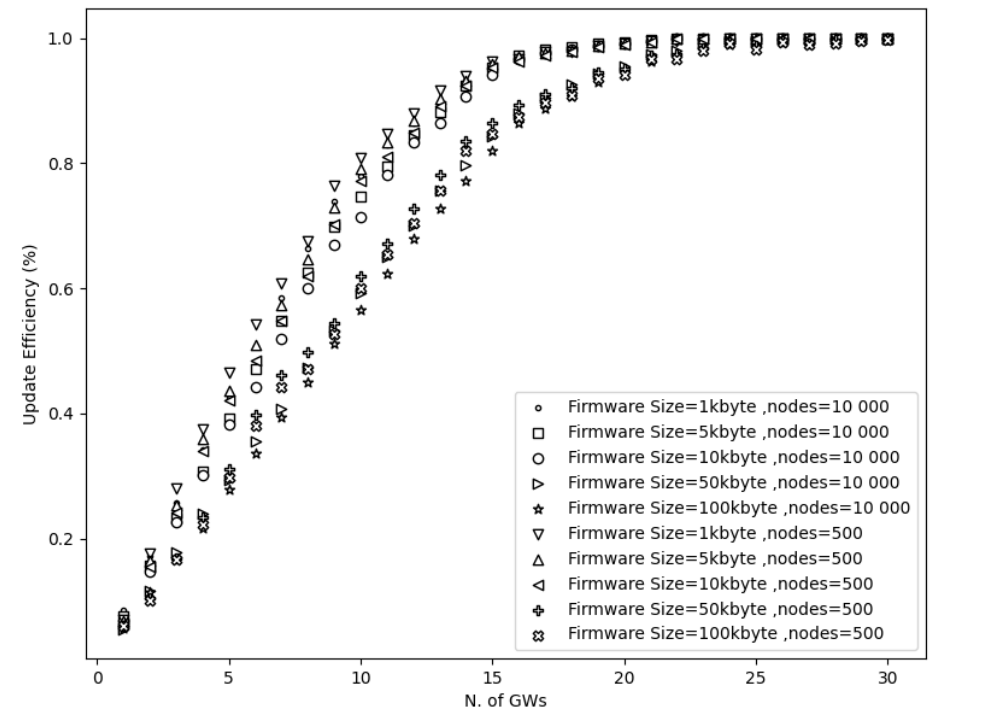
Figure 8. Update efficiency vs. multiple GWs and number of